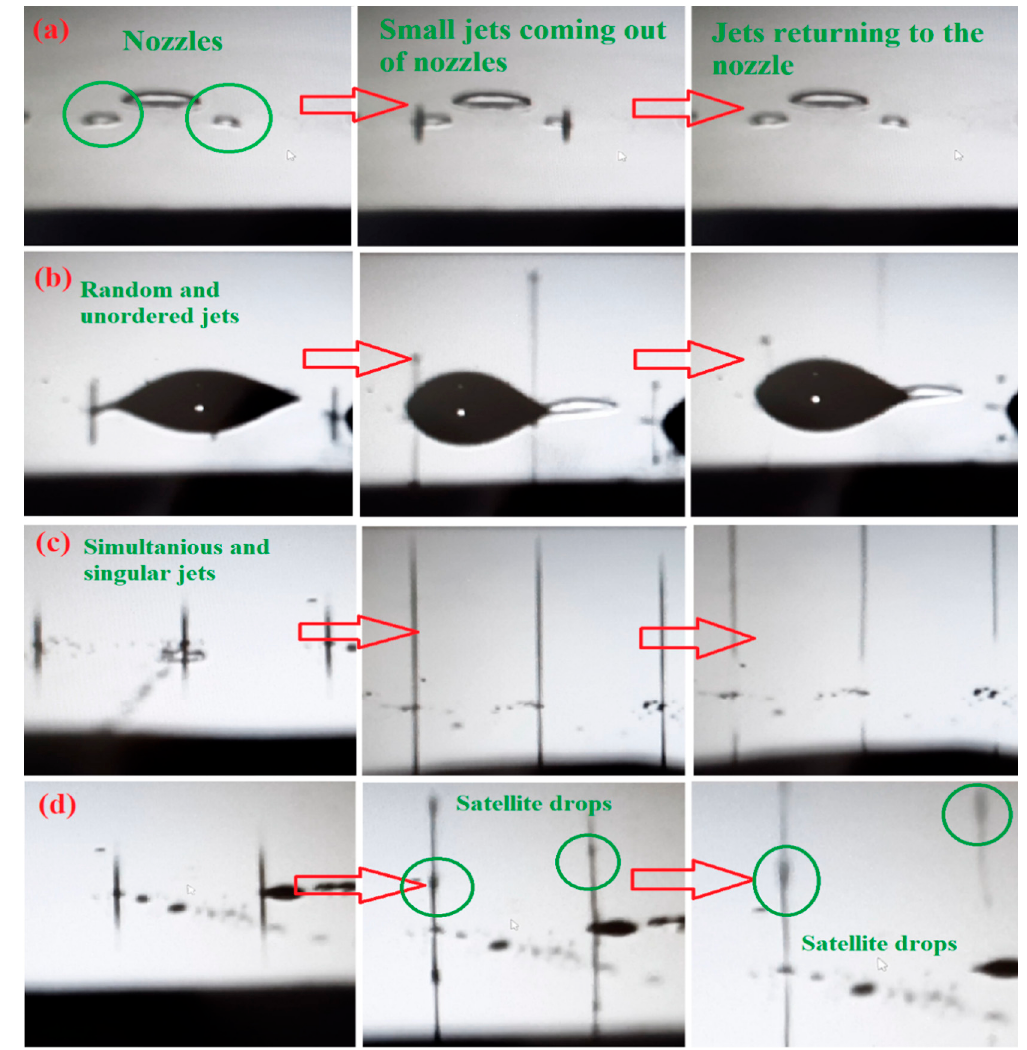
Figure 1. Jetting behavior of fabricated inks, ( a ) no ejection, ( b ) chaotic jet, ( c ) ideal jet, ( d ) satellite drops.